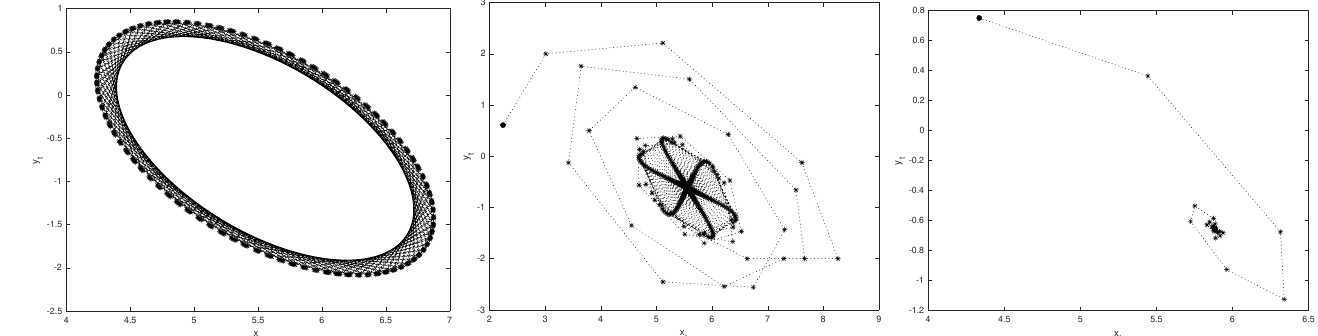
Figure 12. ( left ) shows the phase space of the fundamental map with a = 1.1, b = 0.9 and c = 1 (periodic dynamics), ( middle ) shows the phase space of fundamental and chartist map with a = 1.1, b = 0.9 and c = 1 and e = 2.0, ( right ) shows the phase space of the complete map with the same b values of previous plot and d m =